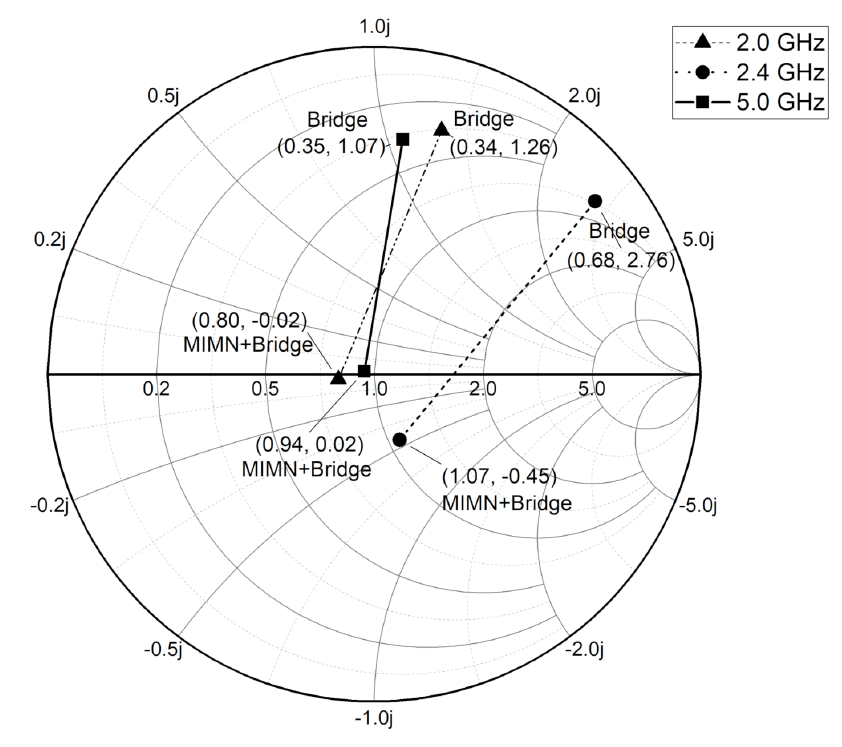
Figure 4. Measured effect of the MIMN in the bridge input impedance represented in the 50 Ω normalized Smith Chart, for 2.0 GHz, 2.4 GHz, and 5.0